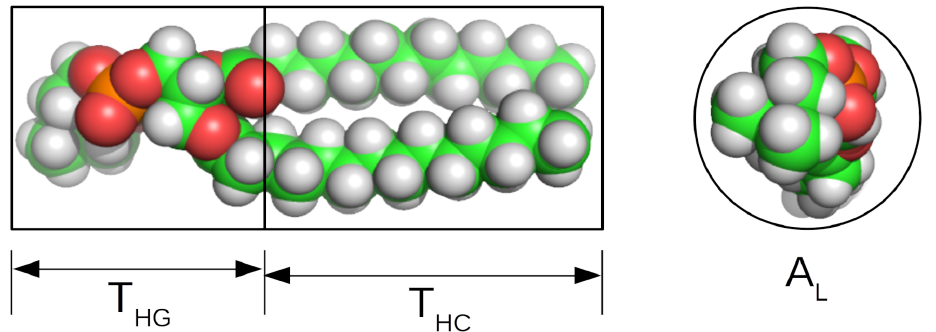
Figure 6. Schematic of parameters used in the self-consistent slab model showing how the lipid layer thickness might be divided into HG and acyl chain regions ( left ), and the area per lipid used to determine D HC and the number of waters associated with the lipid HG ( right ). The lipid was rendered using PyMOL 2.5.2